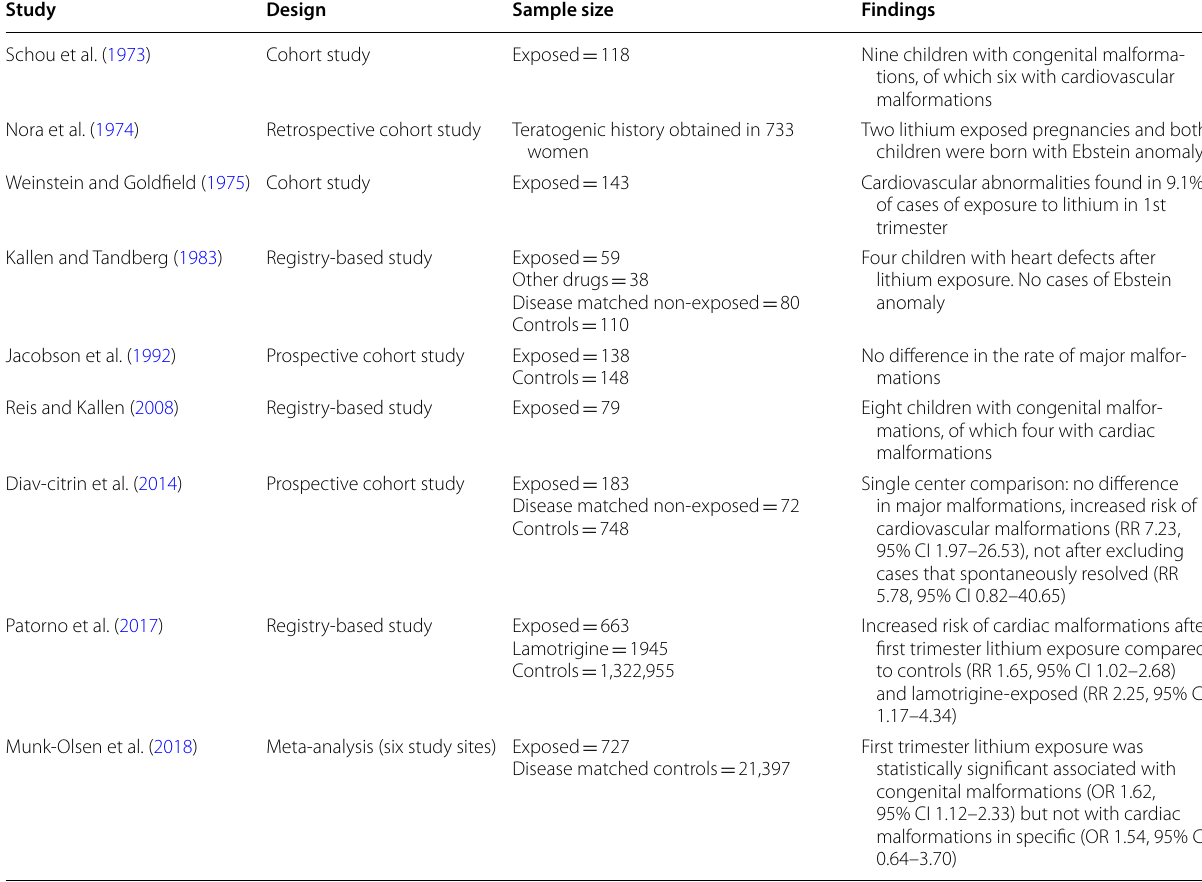
Table 2 Findings from clinical cohort investigations on the association between in utero exposure to lithium and congenital